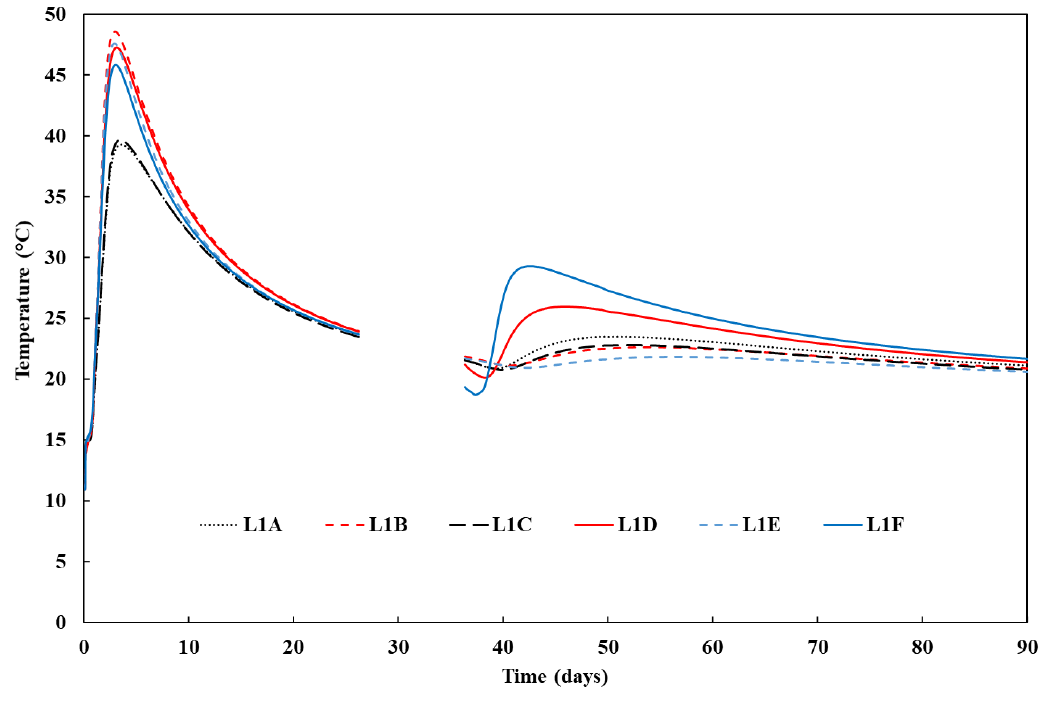
Figure 5: Temperature development in time for